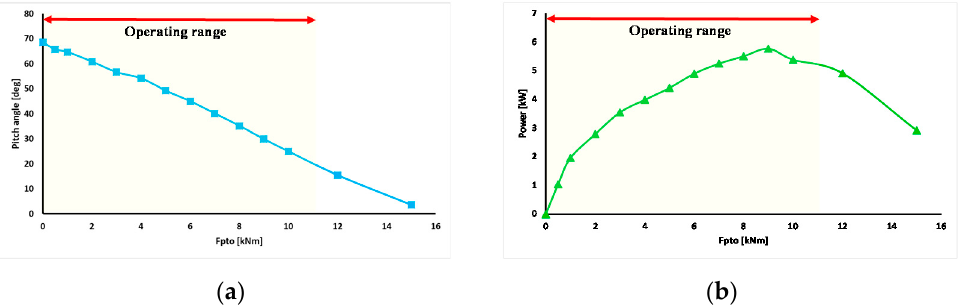
Figure 9. ( a ) Heave motion and ( b ) absorbed power versus PTO force under regular wave condi-